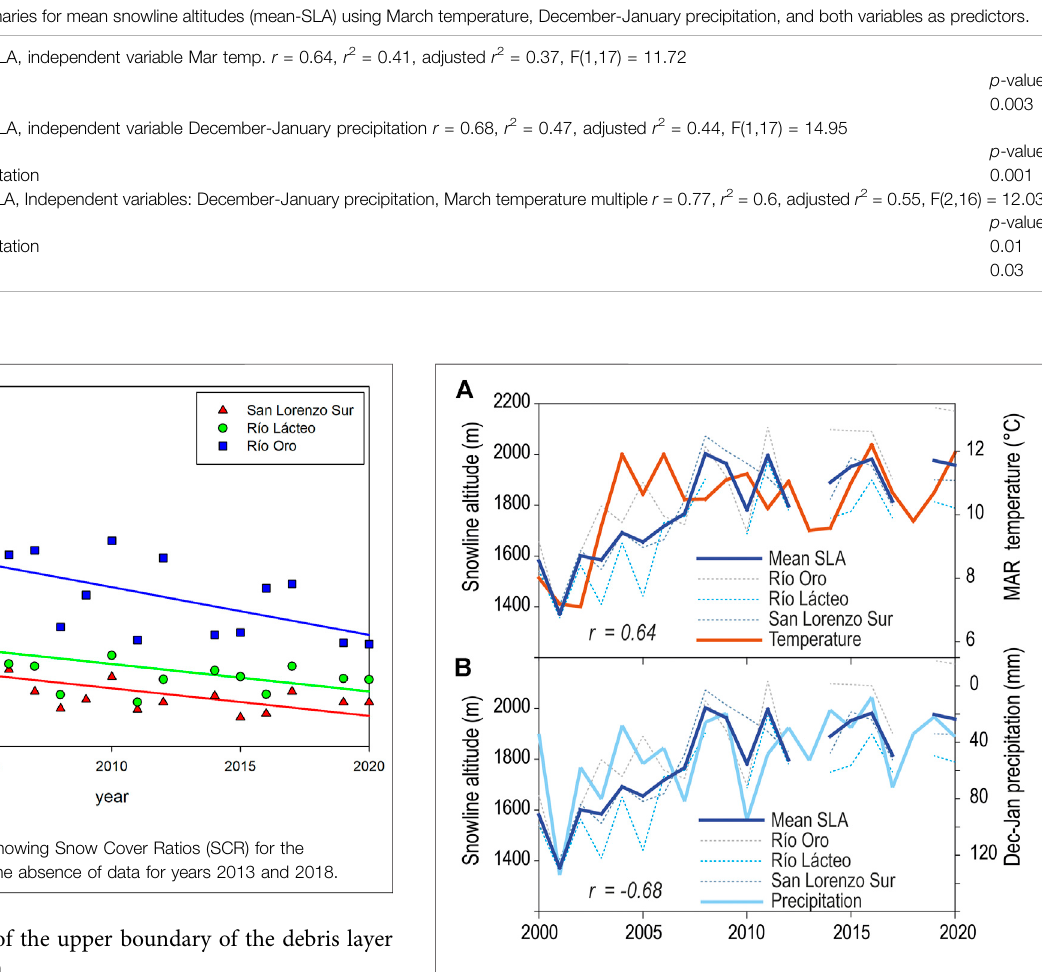
FIGURE 8 | Relationships between variations in yearly snowline altitude, March temperature (A) and accumulated December-January precipitation (B) .